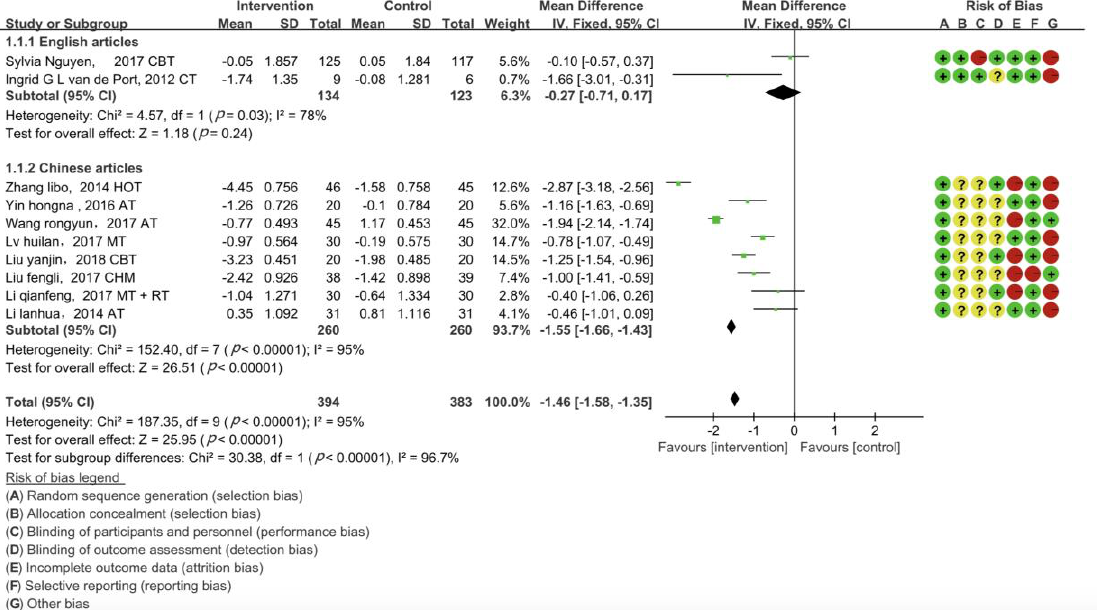
Table 2. Network meta-analysis for interventions.